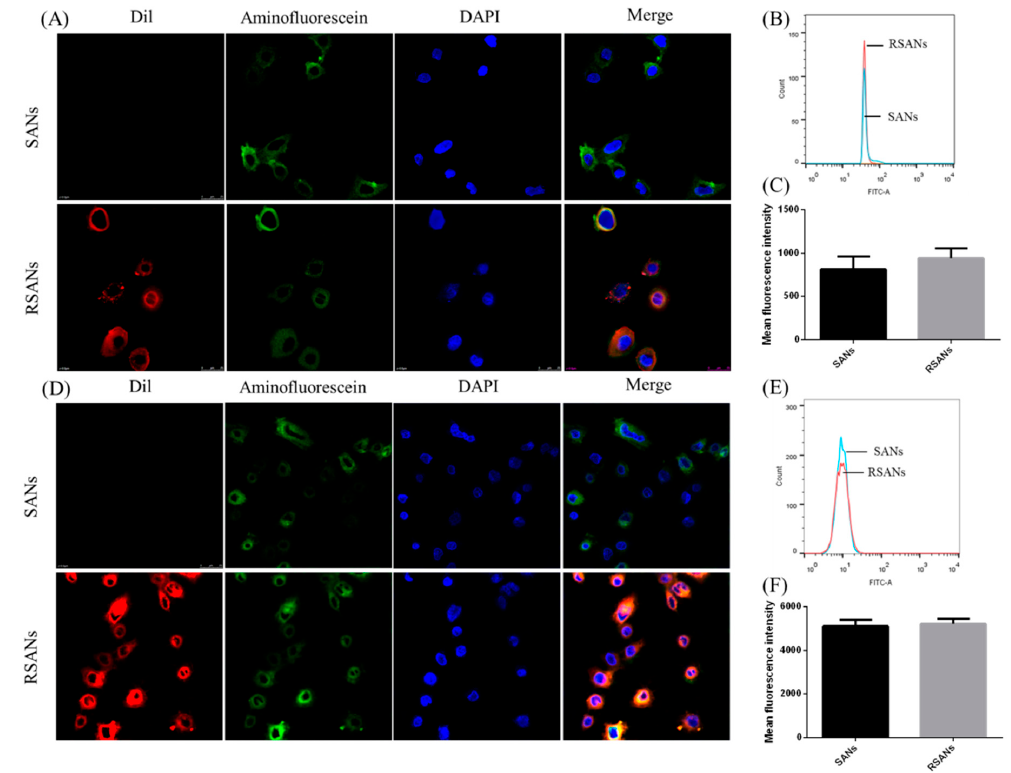
Figure 7. Cellular uptake of SANs and RSANs on NB4 cells and 7721 cells. ( A , D ) Confocal images 630 × . The nucleus of cells was labeled by Hoechst 33342 (blue), SANs were labeled by 5(6)-Aminofluorescein (green) and RBCM were labeled by Dil (red). ( B , E ) Fluorescence intensity detection by flow cytometry. ( C , F ) Quantitative analysis of the fluorescence intensity. Data are shown as ± SD of the mean ( n = 3).